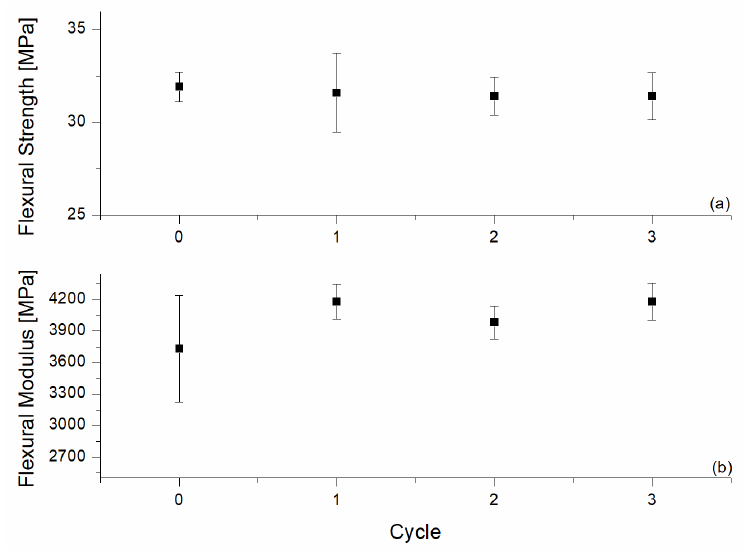
Figure 12. Tensile testing results of the reinforced H20 blends with different as a function of the recycling cycle. ( a ) Flexural Strength; ( b ) Flexural Modulus.